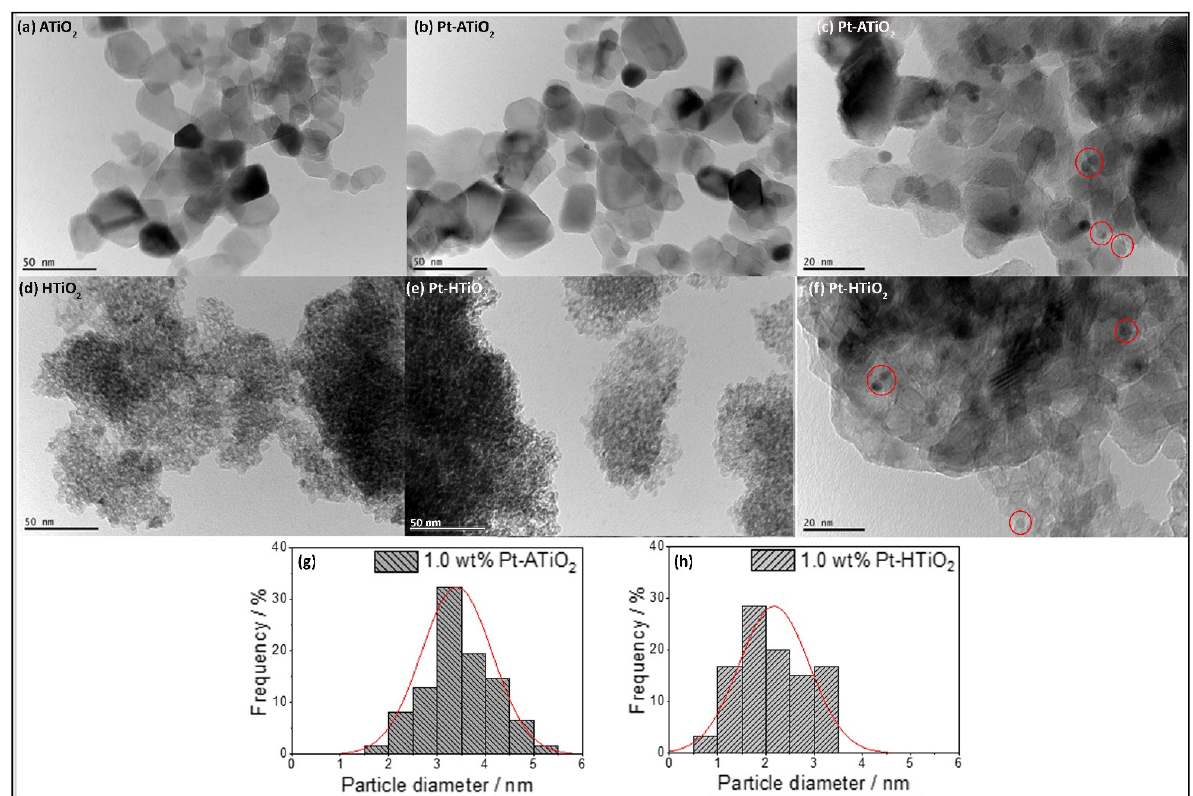
Figure 3. High ‐ resolution transmission electron micrographs (HR ‐ TEM) of pristine ATiO 2 ( a ), 1.0 wt% Pt ‐ ATiO 2 ( b , c ), Figure 3. High-resolution transmission electron micrographs (HR-TEM) of pristine ATiO 2 ( a ), 1.0 wt% Pt-ATiO 2 ( b , c ), pris- pristine HTiO 2 ( d ), and 1.0 wt% Pt ‐ HTiO 2 ( e , f ). Pt particle diameter distribution images for 1.0 wt% Pt ‐ ATiO 2 ( g ) and 1.0 tine HTiO 2 ( d ), and 1.0 wt% Pt-HTiO 2 ( e , f ). Pt particle diameter distribution images for 1.0 wt% Pt-ATiO 2 ( g ) and 1.0 wt% wt% Pt ‐ HTiO 2 ( h ). Pt-HTiO 2 ( h